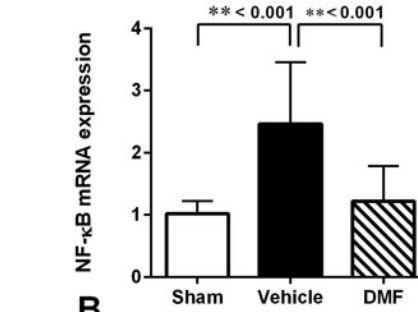
FIGURE 7 - The expression of Nrf2 (A) and NF-κB (B) in the brain cortex of the right hemisphere 72 h after one h brain ischemia in the sham, vehicle, dimethyl fumarate (DMF) -treated rats (n = 6 rats/group). ** P <0.001.